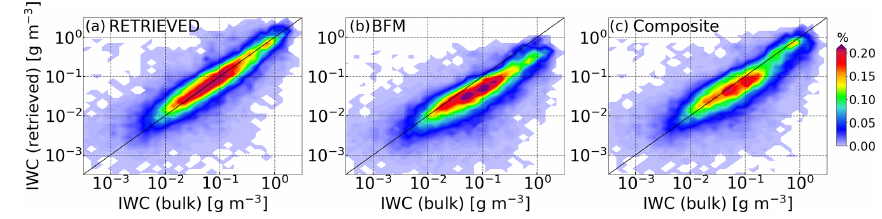
Figure 4. Comparison between the measured IWC (horizontal axis) and the retrieved IWC using different mass–diameter relationships (vertical axis): RETRIEVED (Delanoë et al., 2014) (a) , BFM (Brown and Francis, 1995; Mitchell, 1996) (b) , and Composite (Heymsfield et al., 2010) (c) .